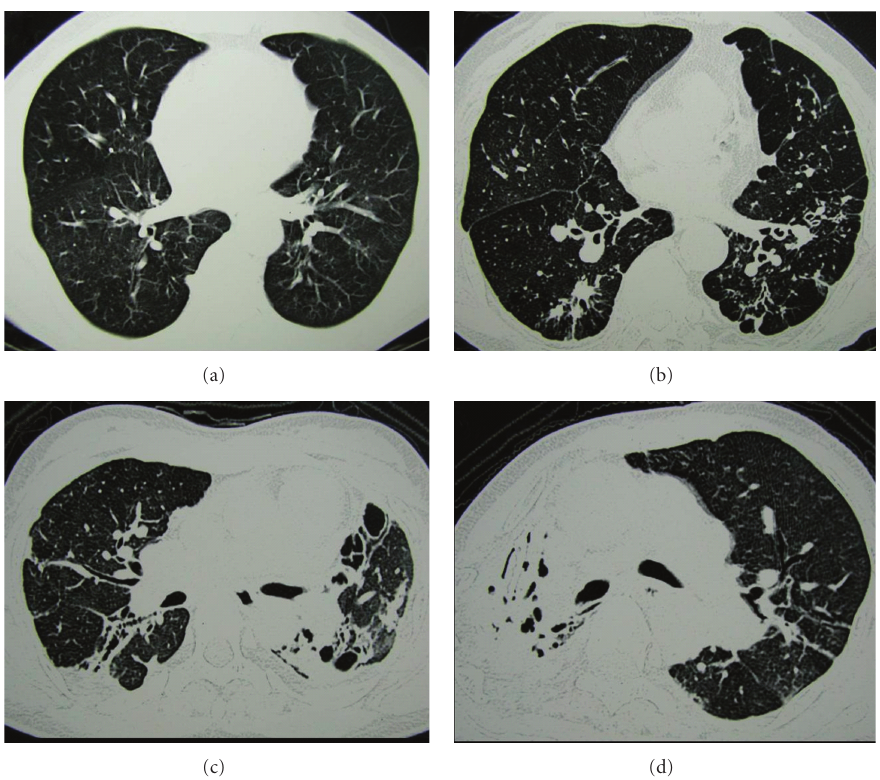
Figure 1: Some examples for grading the extent of TDL. (a) There was no abnormality, and a score of 0 was assigned. (b) A score of 1 was given, as less than 25% of the lung parenchyma showed destroyed lesion. (c) Destroyed lung lesion involved 50–75% of the lung parenchyma, and a score of 3 was assigned. (d) Destroyed lung lesion involved more than 75% of the lung parenchyma, therefore a score of 4 was assigned.